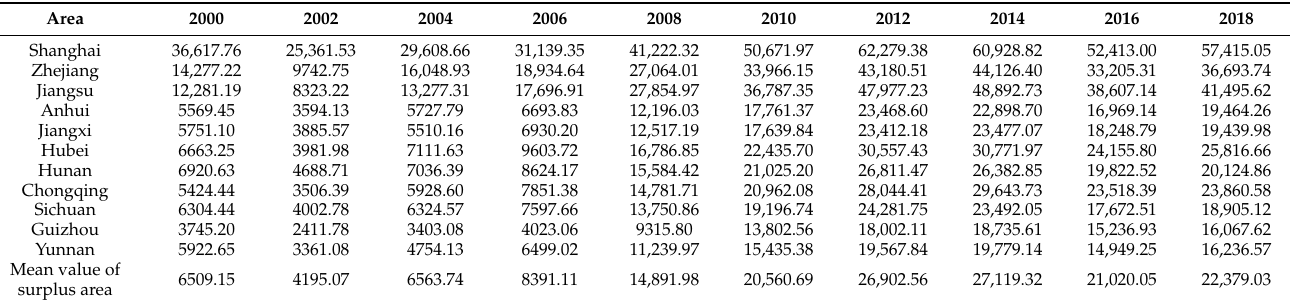
Table 3. The value of nonagricultural benefits of cultivated land per unit in the Yangtze River Economic Belt from 2000 to 2018 (CNY/hm 2